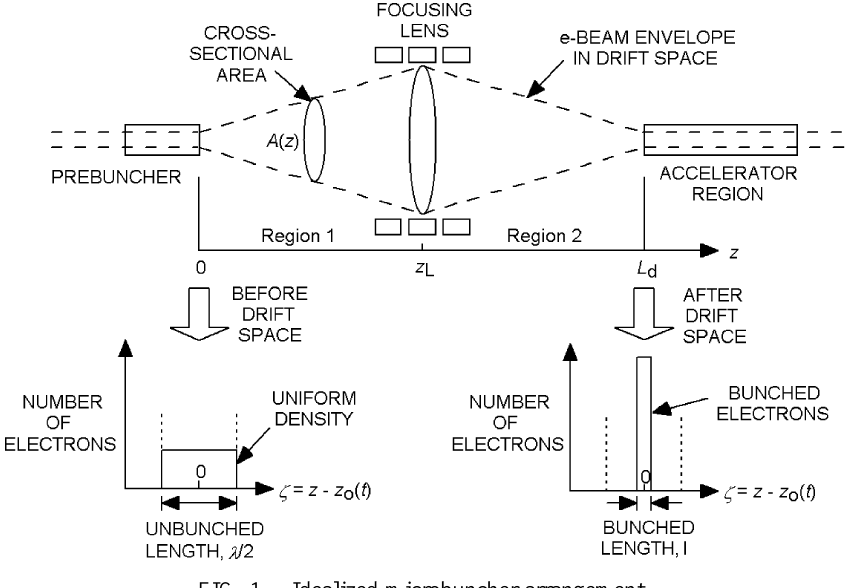
FIG. 1. Idealized microbuncher